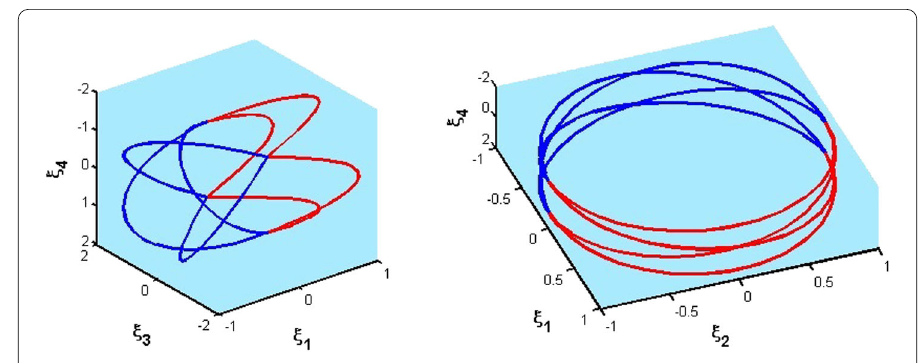
Figure 9 Period-four orbit appears at K =